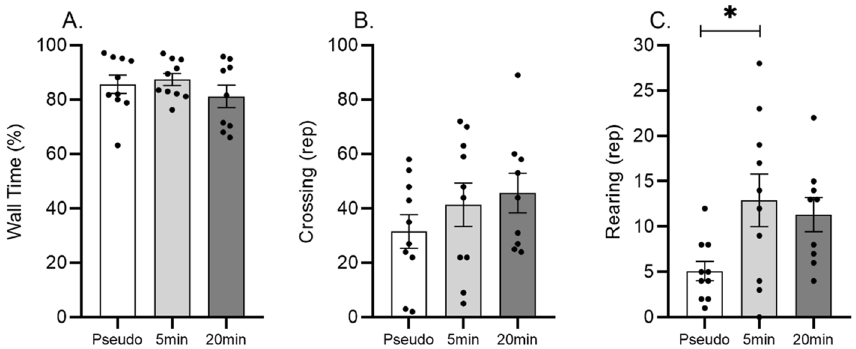
Figure 2. The effects of 5 and 20 min daily sessions of WBV on exploratory and anxiety-related behavior in the open field in aged male rats. The time spent at wall (panel A ), number of crossings (panel B ) and frequency of rearings (panel C ). One-way ANOVA was used to reveal statistical difference between the experimental groups. Data are depicted as mean ± SEM. * indicates P <